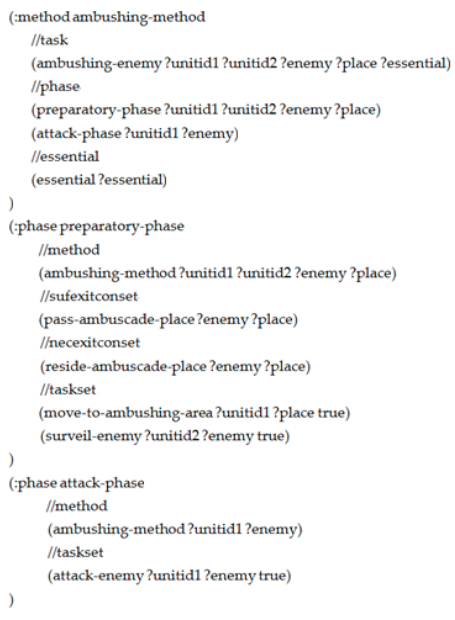
Figure 1 . An example of the ambushing-enemy task. Figure 1. An example of the ambushing-enemy